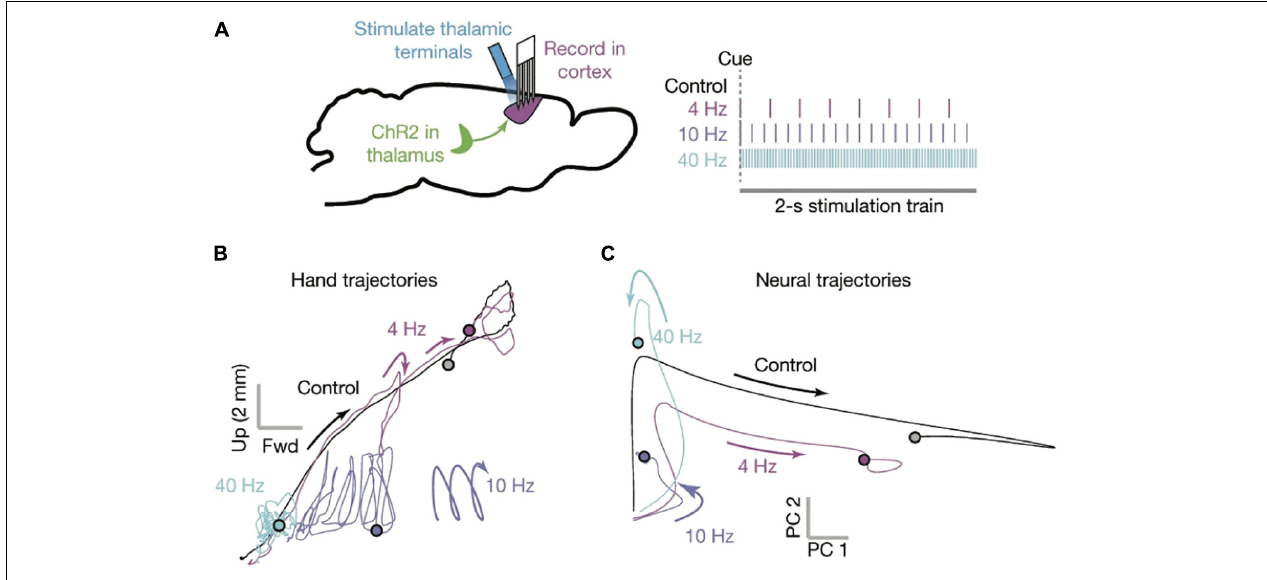
FIGURE 4 | The motor cortex as a dynamical system. (A) Multisite single unit recordings were made from primary motor cortex (M1) as mice performed skilled reaching (left). Thalamocortical terminals in M1 (likely from both BG- and CB-Mthal) were optogenetically activated at varying frequencies (right). (B) Paw trajectories under different stimulation conditions. Mice made smooth reaches in the absence of stimulation. Paw trajectories were perturbed by 4 Hz stimulation. 10 Hz stimulation created oscillating paw trajectories, reminiscent of action tremor. 40 Hz stimulation severely limited paw movement. (C) Neural state space trajectories under different stimulation conditions. 4 Hz stimulation shrunk the state space trajectory, while 10 and 40 Hz stimulation severely truncated the state space rotation. PC1 and PC2 indicate the first two principal components of the neuronal firing rate state space. Adapted with permission from Sauerbrei et al.